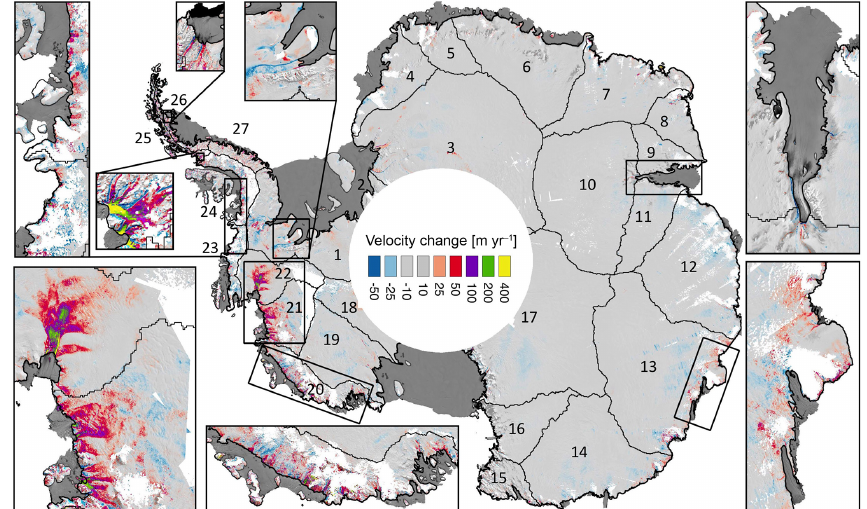
Figure 9. Change in surface velocities between date of pan-Antarctic SAR mapping (Rignot et al., 2011a, circa 2008) and new 2015 velocity mapping produced here from feature tracking of Landsat 8 imagery. Change in velocities shown for grounded ice only. Missing data shown in white and the 27 basin boundaries defined by Zwally et al. (2002) are shown in